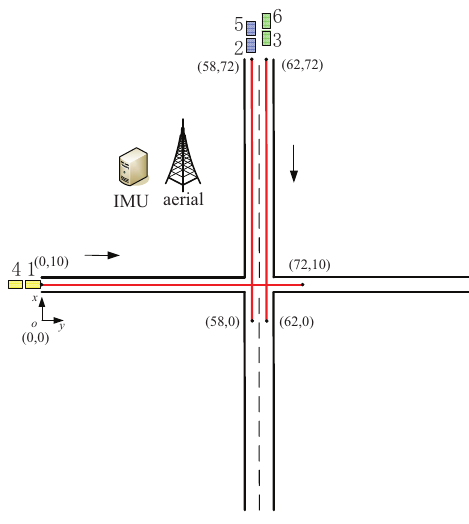
Figure 13. Simplified